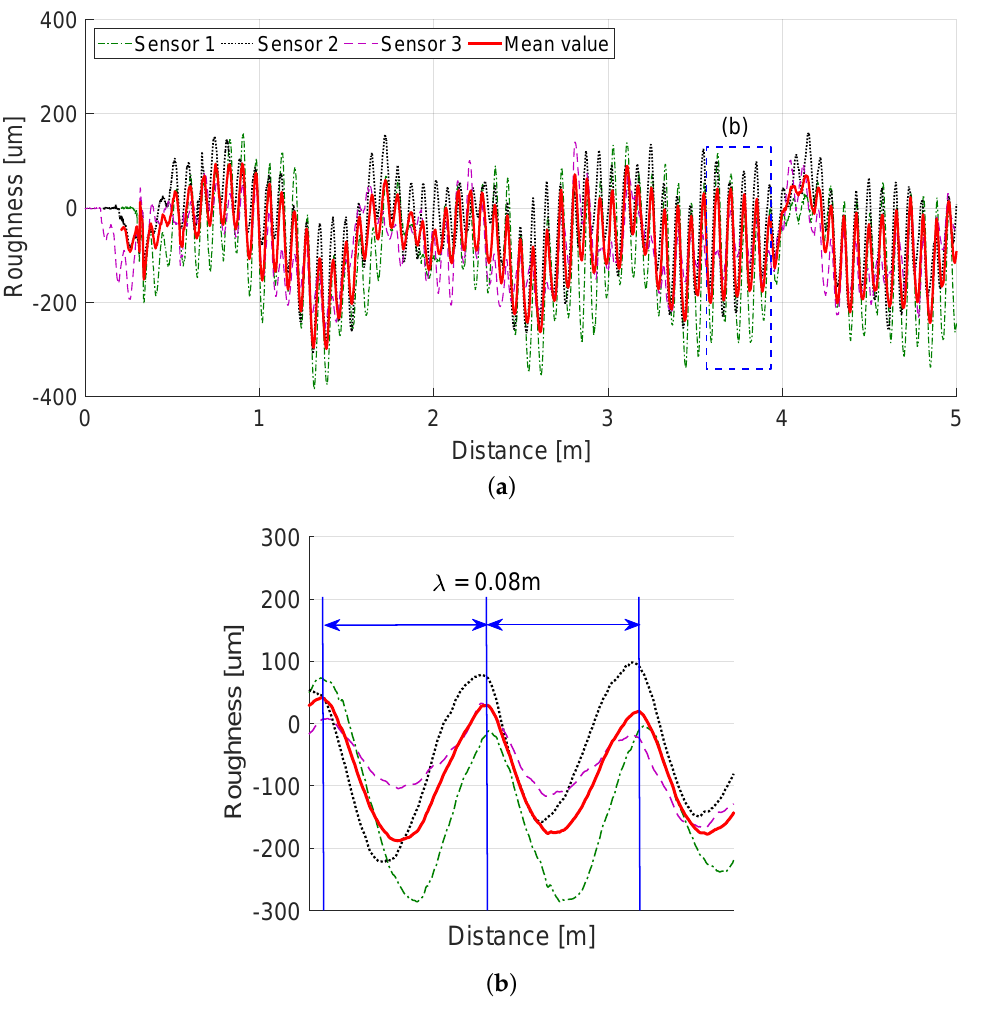
Figure 17. ( a ) Longitudinal railhead roughness of Track B; ( b ) magnified area of the railhead roughness.